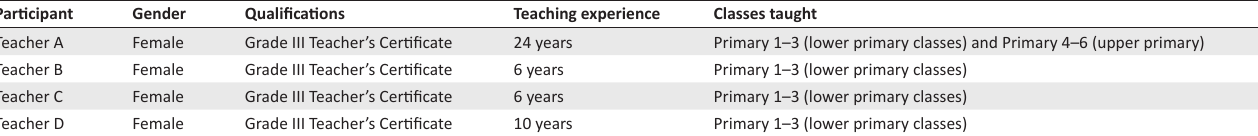
TABLE 1: Biographical information of teacher participants.